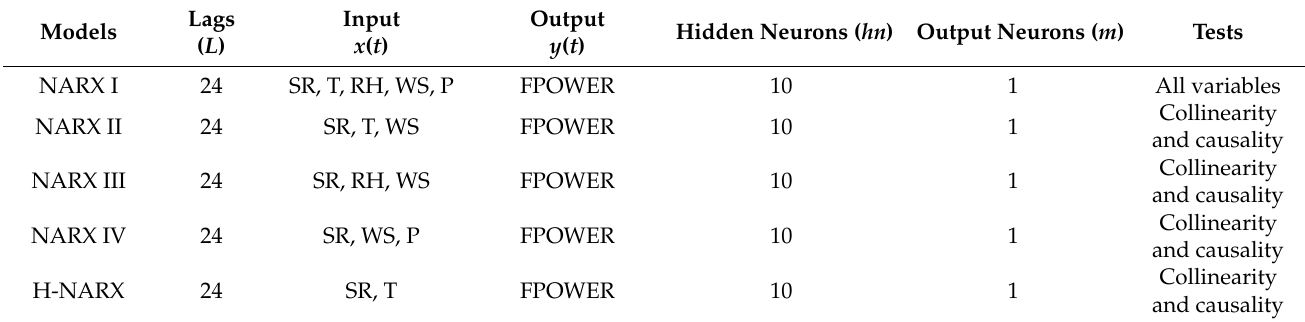
Table 7. Architectures used to generate the NARX models.